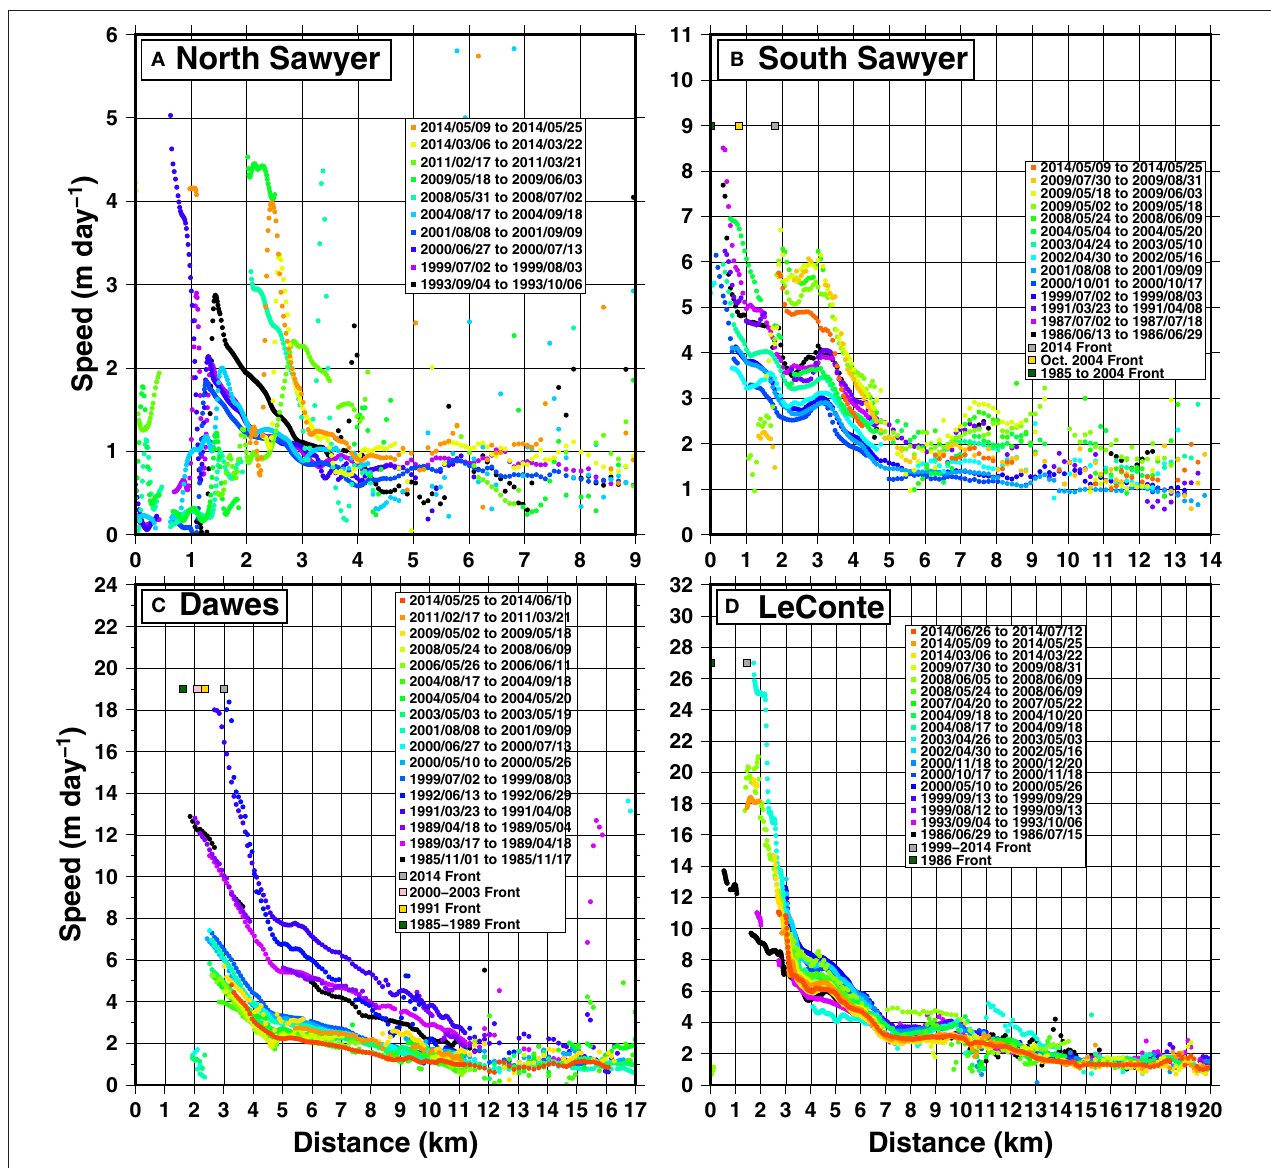
FIGURE 4 | Centerline profiles of speeds between 1985 and 2014 for selected pairs at North Sawyer (A), South Sawyer (B), Dawes (C), and LeConte (D) glaciers. Front positions (determined from Landsat imagery) at selected dates indicated by squares.